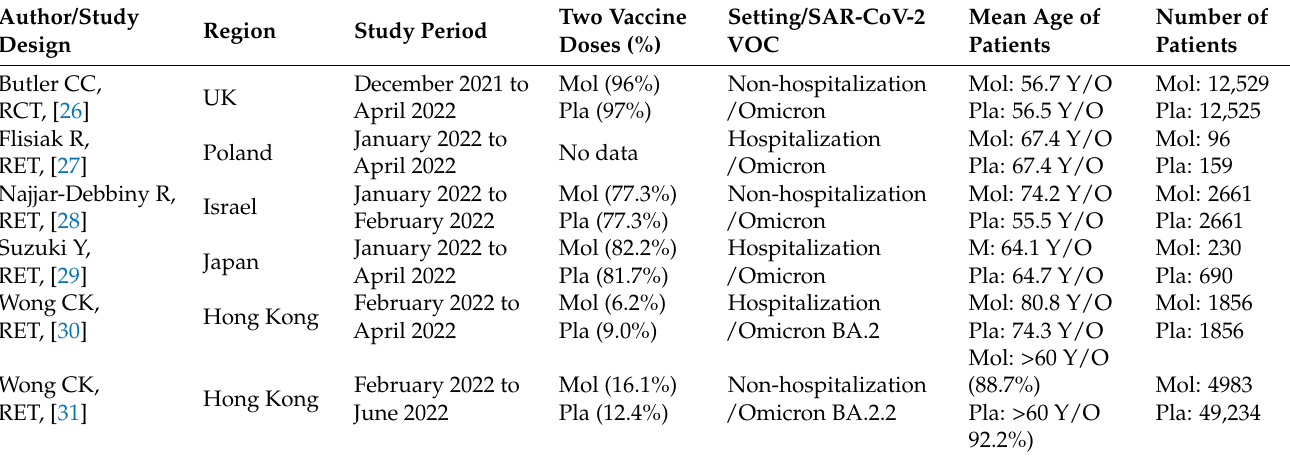
Table 1. Characteristics of the included studies.